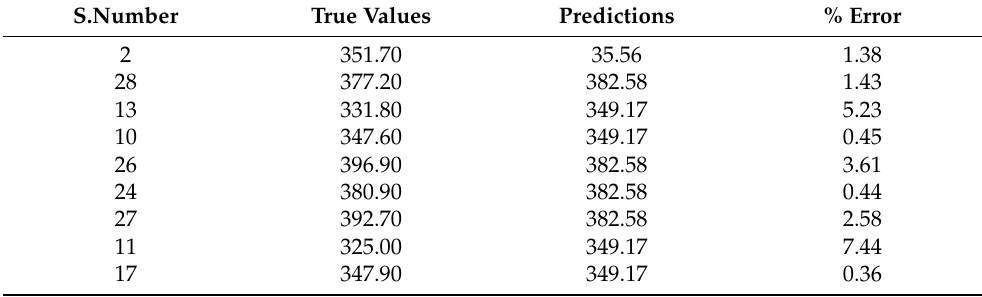
Table 5. Training predictions vs true